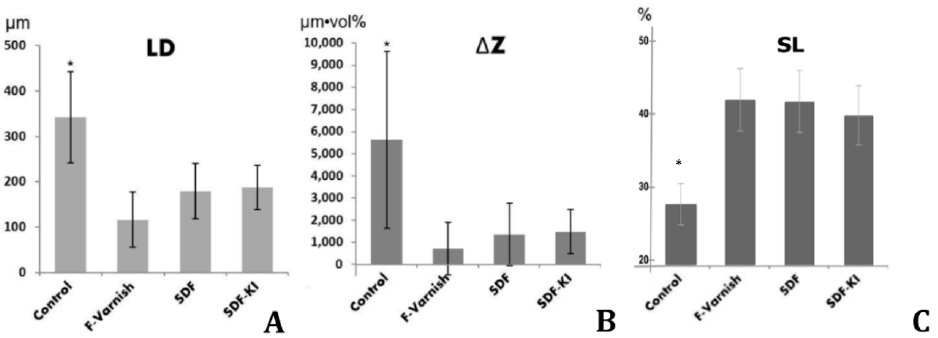
Figure 3. Results of all groups; ( A ) lesion depth (LD); ( B ) mineral loss ( ∆ Z); ( C ) surface layer mineral density (SL). Asterisk (*) indicates significantly different group in each parameter (p < 0.05).